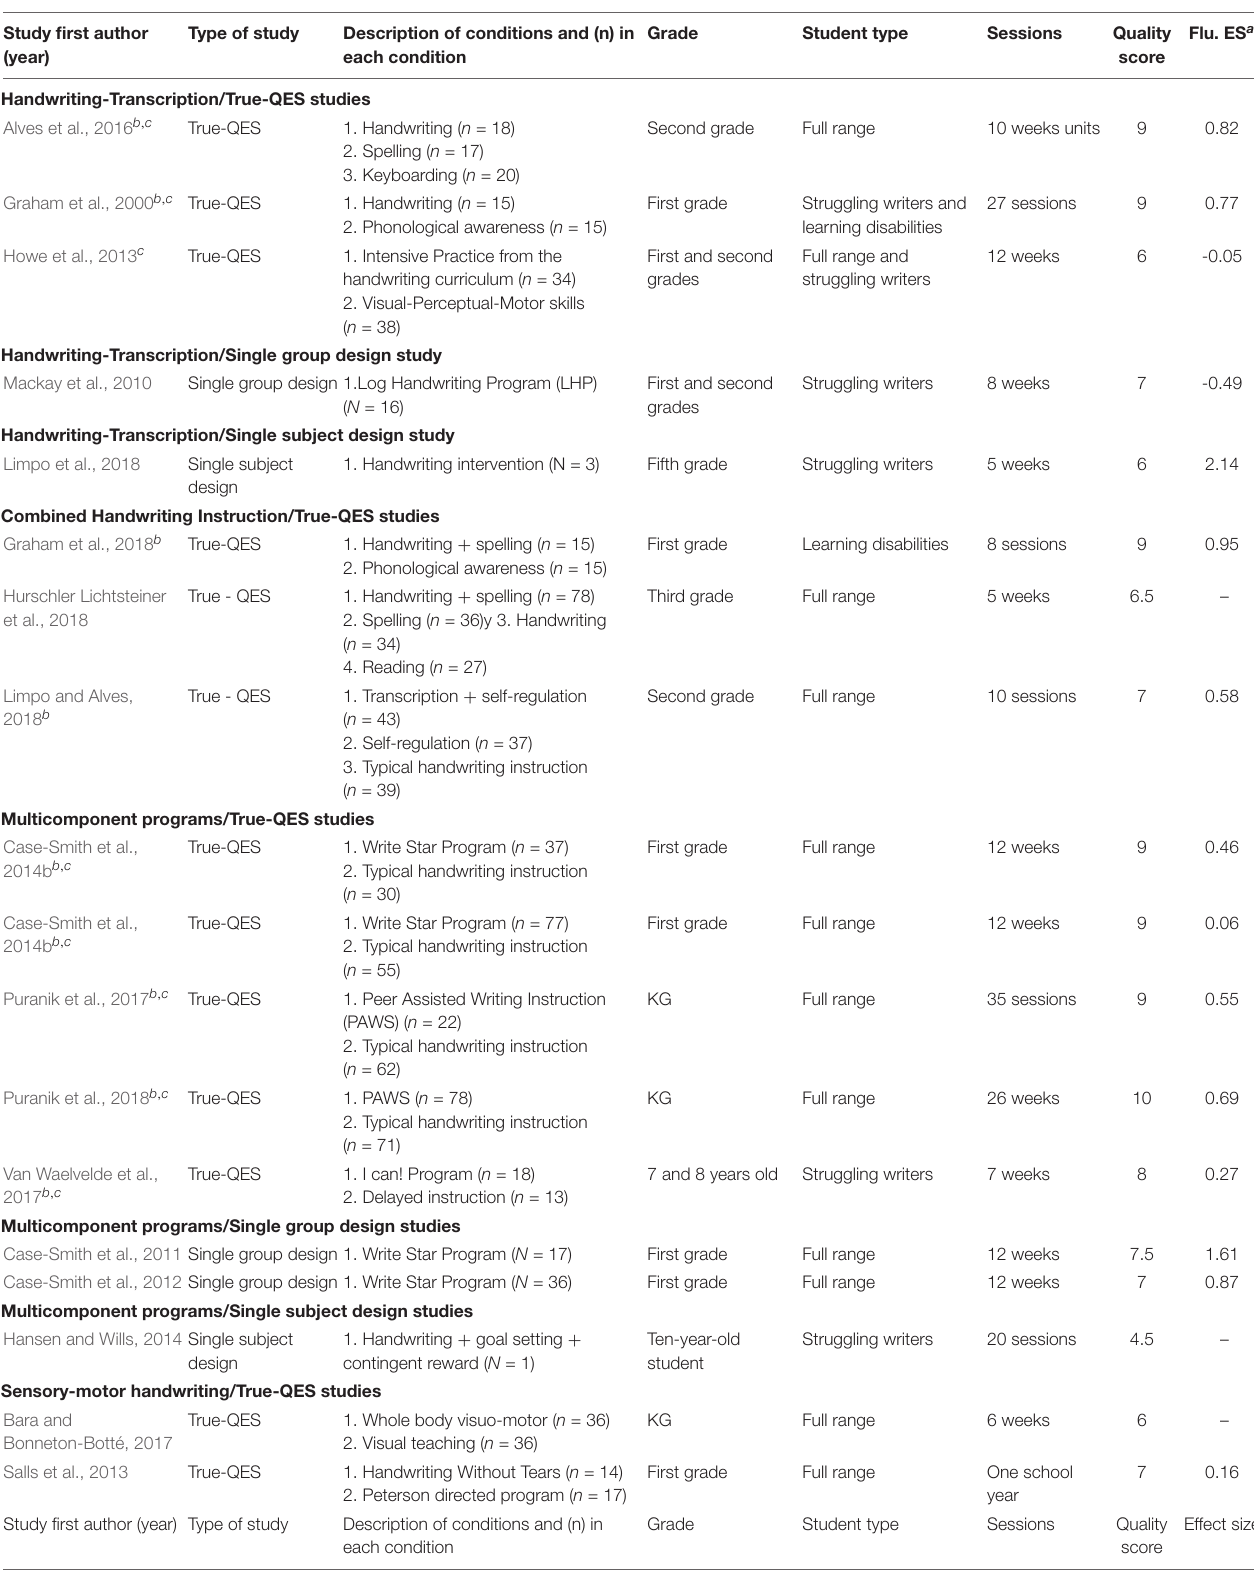
TABLE 1 | Summary of reviewed studies categorized by intervention